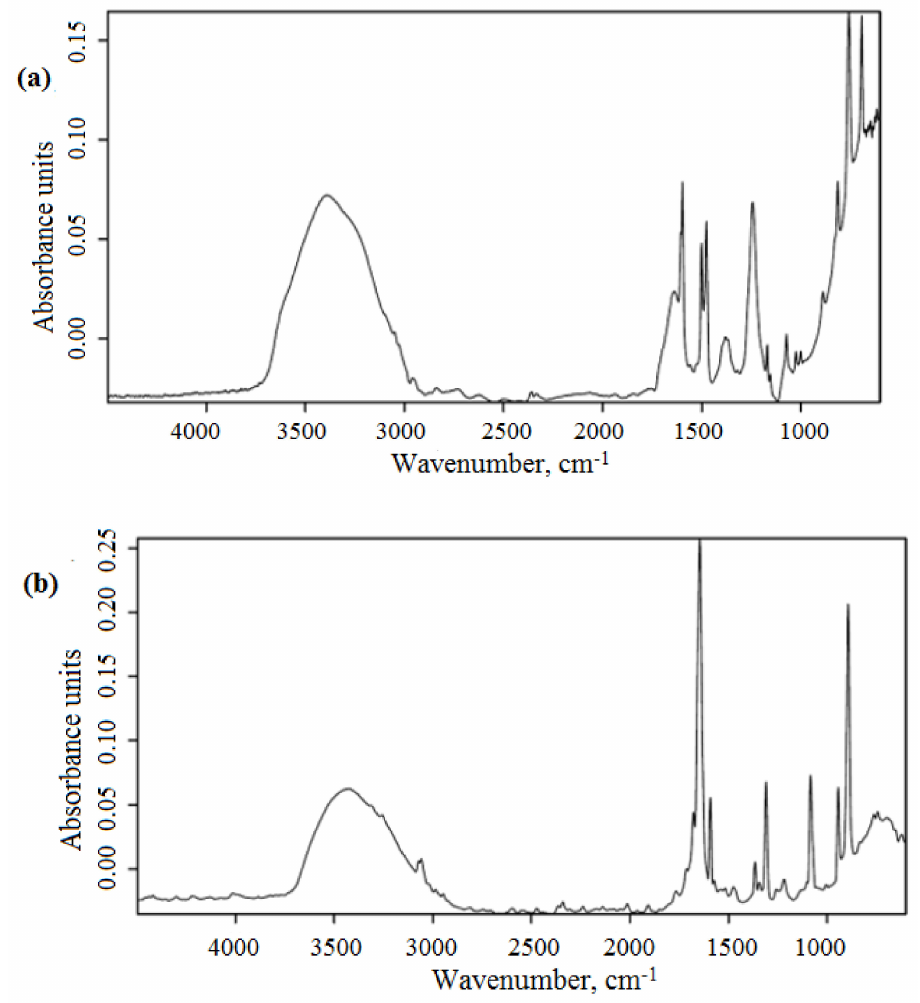
Figure 17. IR spectra of the initial aqueous solution of phenol before ( a ) and after ( b )